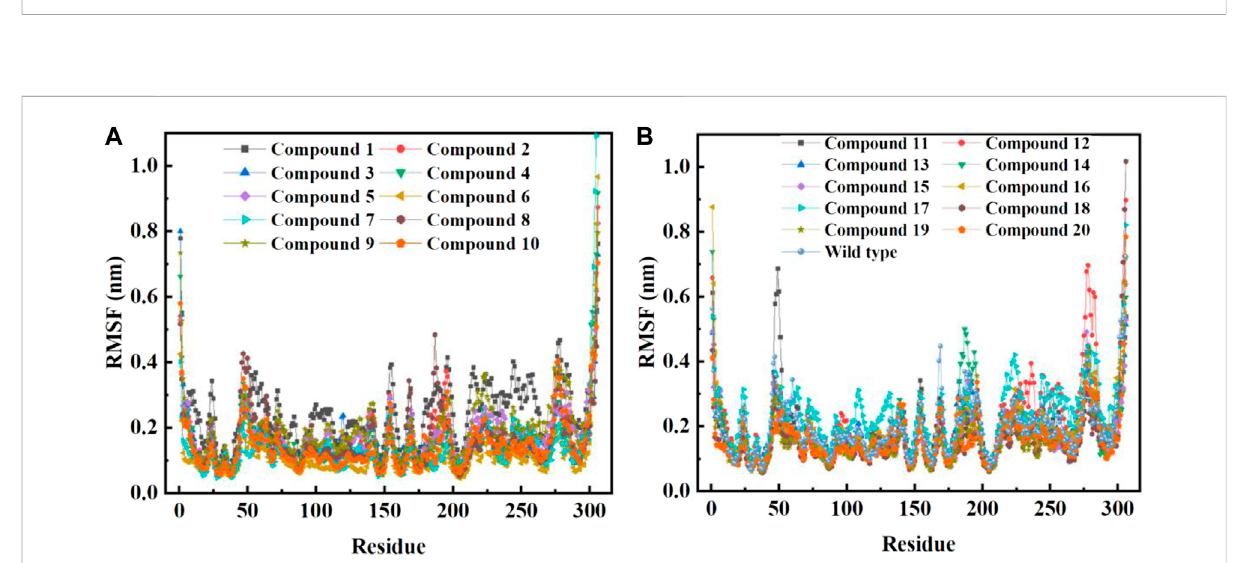
FIGURE 9 The changes in the number of H-bonds during the MD trajectory of different M pro -ligand system or wild M pro .